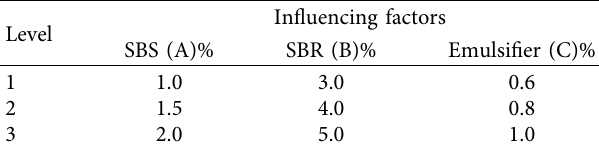
Table 6: Test factors and